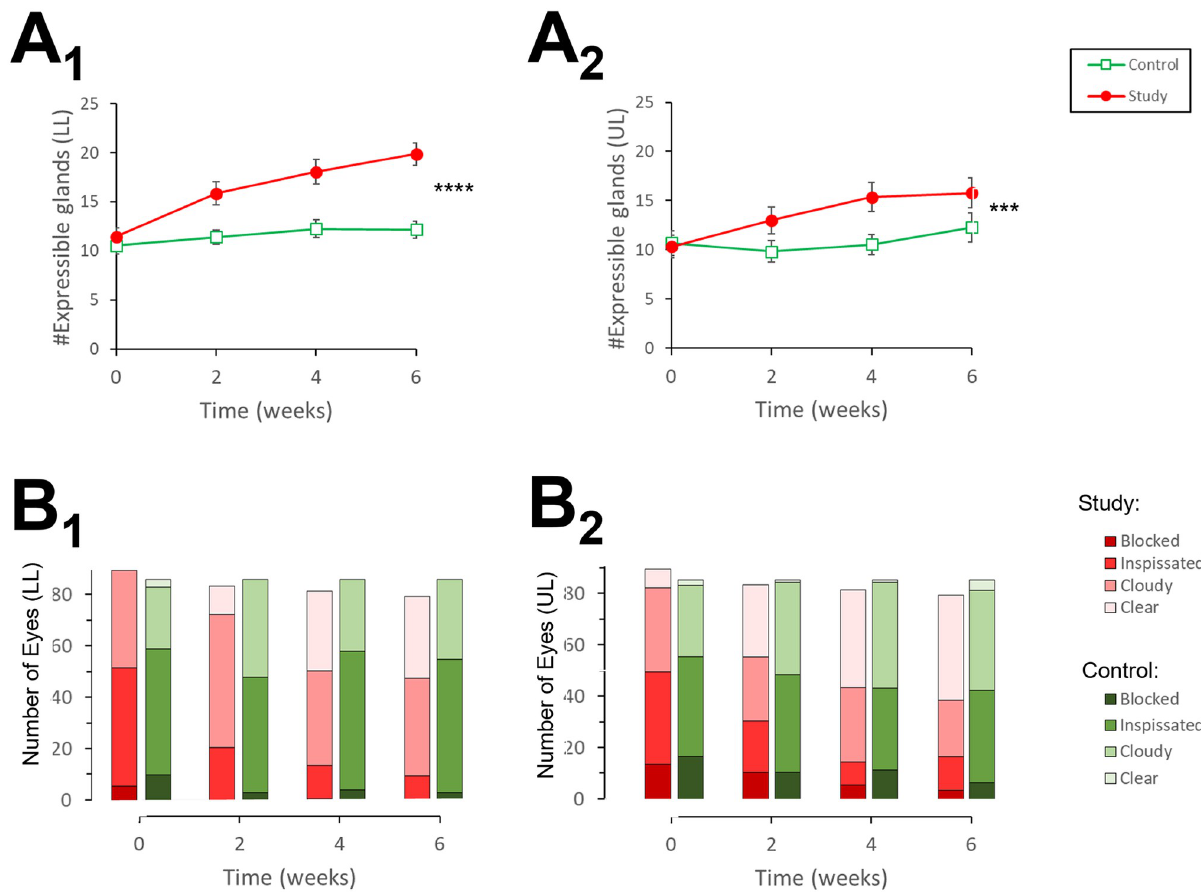
Fig 5. Number of expressible glands and meibum quality as function of time. Time: 0 = Tx 1, 2 weeks = Tx 2, 4 weeks = Tx 3, 6 weeks = Tx 4; A. Number of expressible gland in lower lids (A1) and upper lids (A2). Error bars: SEM; ��� : P (between arms) < 0.001; ���� : P (between arms) < 0.0001. B. Distribution of predominant quality of meibum (blocked, inspissated, cloudy liquid, clear liquid) in study and control eyes. B1: lower lids. B2: upper lids.